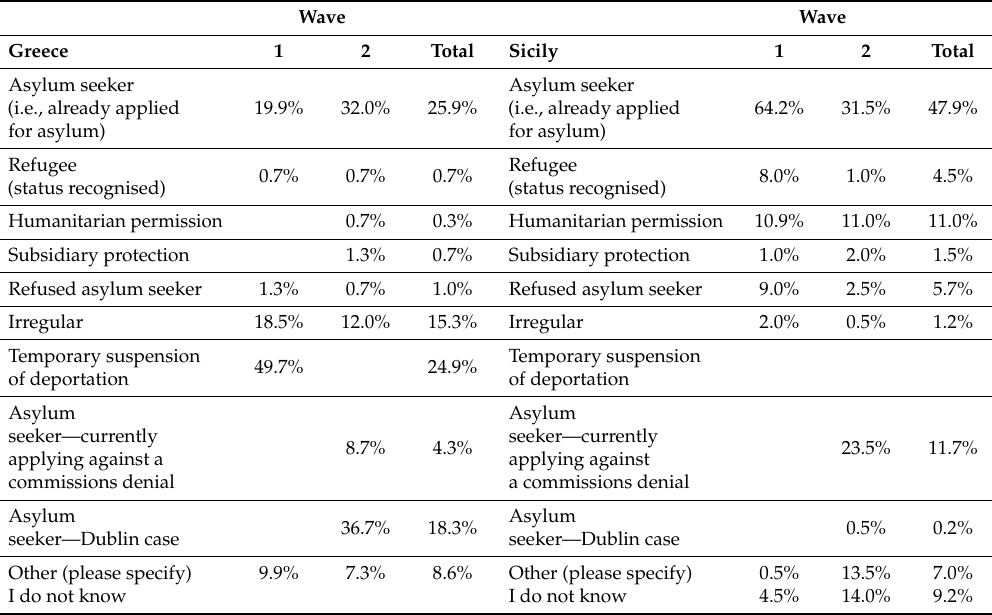
Table 2. Legal status (responses by country across the two